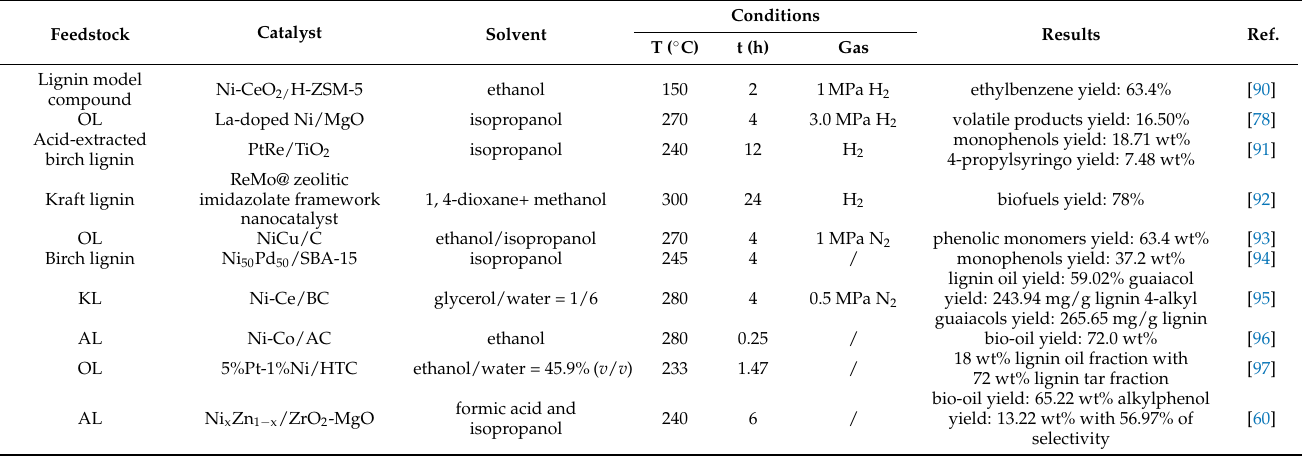
Table 4. Summary of catalytic depolymerization of lignin using bimetallic